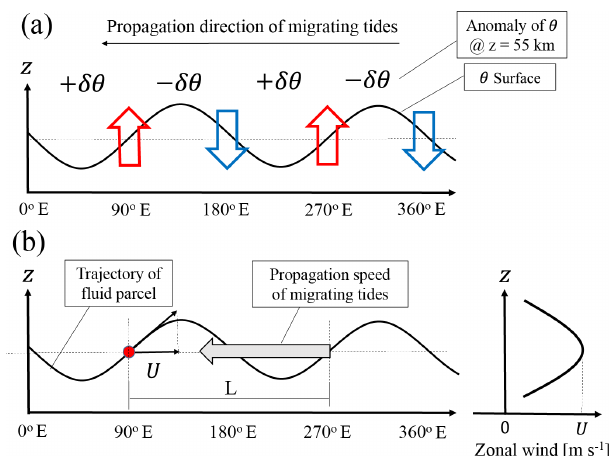
Figure 17. (a) A schematic figure of longitudinal locations of anomalies of θ ( δθ) from the zonal mean due to the semidiurnal tide and associated vertical wind couplets denoted by large arrows at a height of the core of the polar night jet. (b) A trajectory of fluid parcel on a θ surface at the height of polar night jet. The thin dashed arrow denotes a motion of the fluid parcel, and U denotes the magnitude of the background zonal wind.